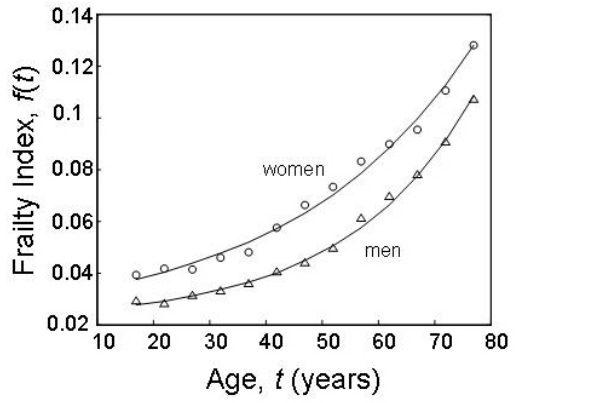
FIGURE 1 . Accumulation of the proportion of deficits (frailty trajectories) with chronological age for men and women. Experimental data are the proportion of deficits average across the same age group. Age group is represented by the midpoint, e.g., from 50 to 55 years represented by the point at 52 years. Solid lines represent fitting curves according to the two-component model, Eq.